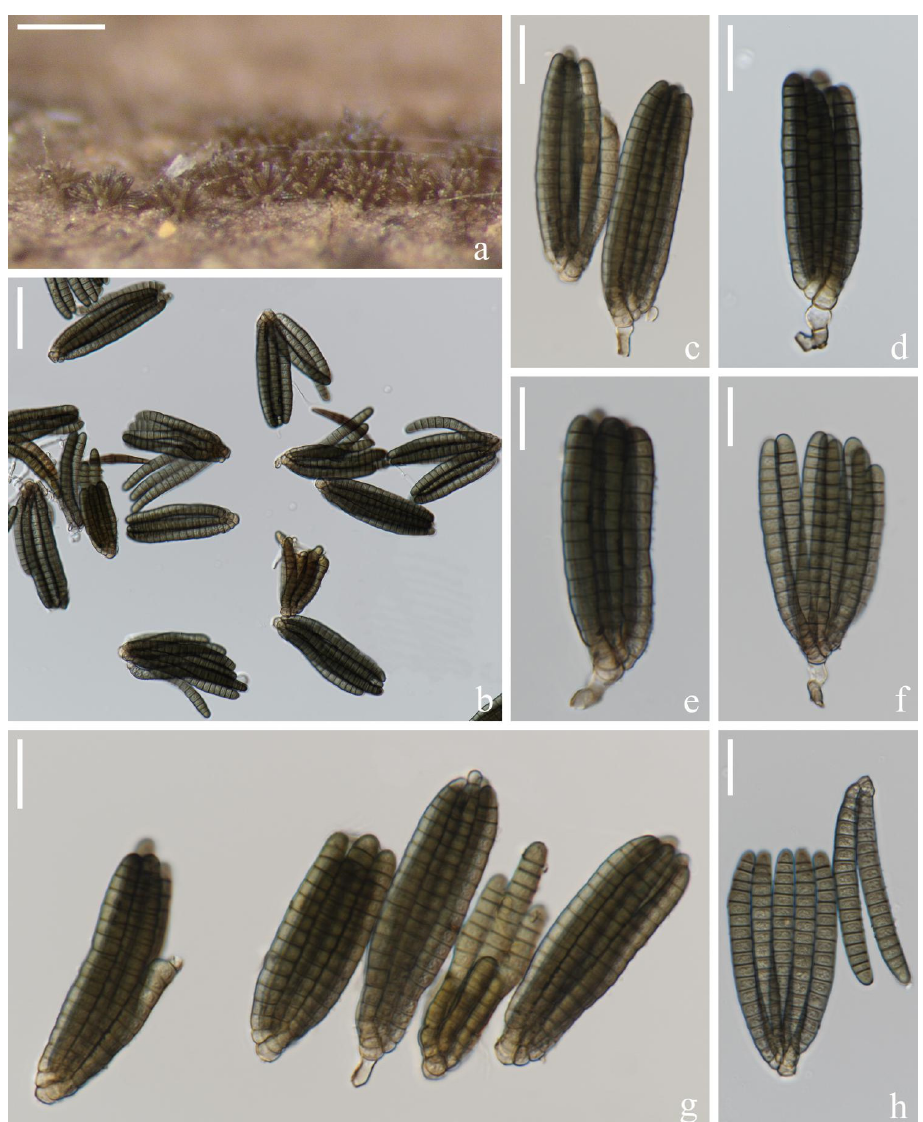
Figure 7. Dictyocheirospora heptaspora (MFLU 22-0202). ( a ) Colonies on the substratum. ( b , c ) Conidiophores and conidiogenous cells. ( d , e ) Conidiogenous cells with conidia. ( g , h ) Conidia. Scale bars: ( a ) 200 μ m, ( b ) 40 μ m and ( c – h ) 20 μ m.